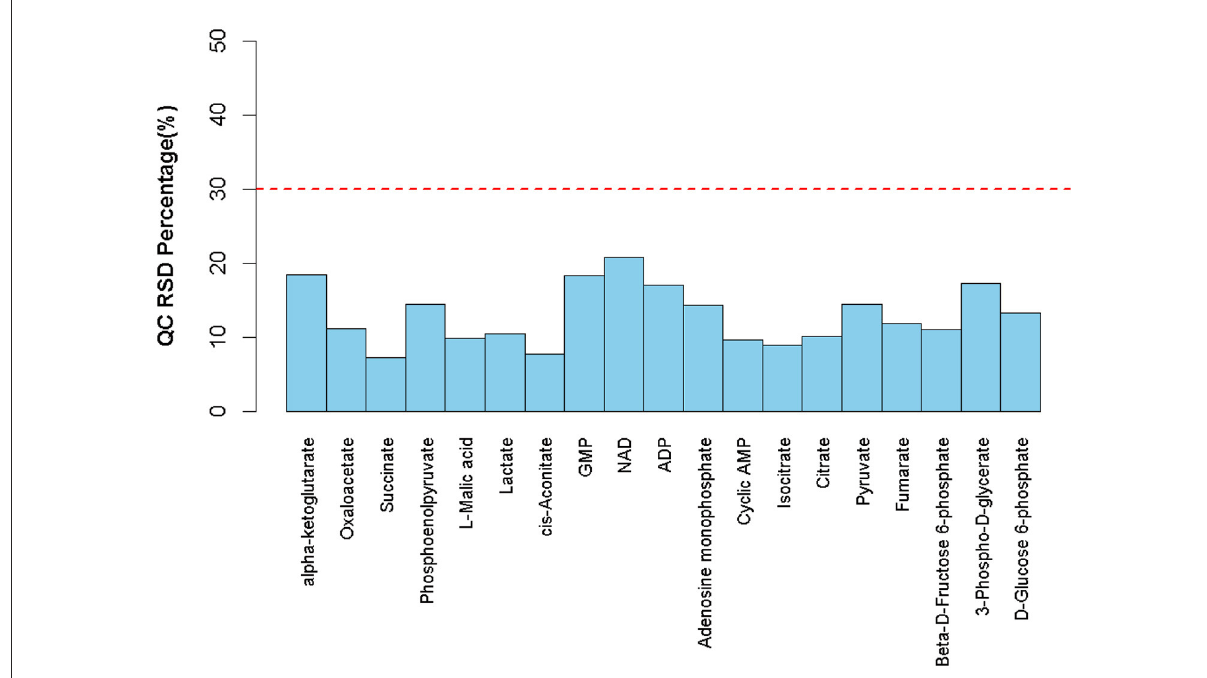
FIGURE8 RSD distribution of QC samples.